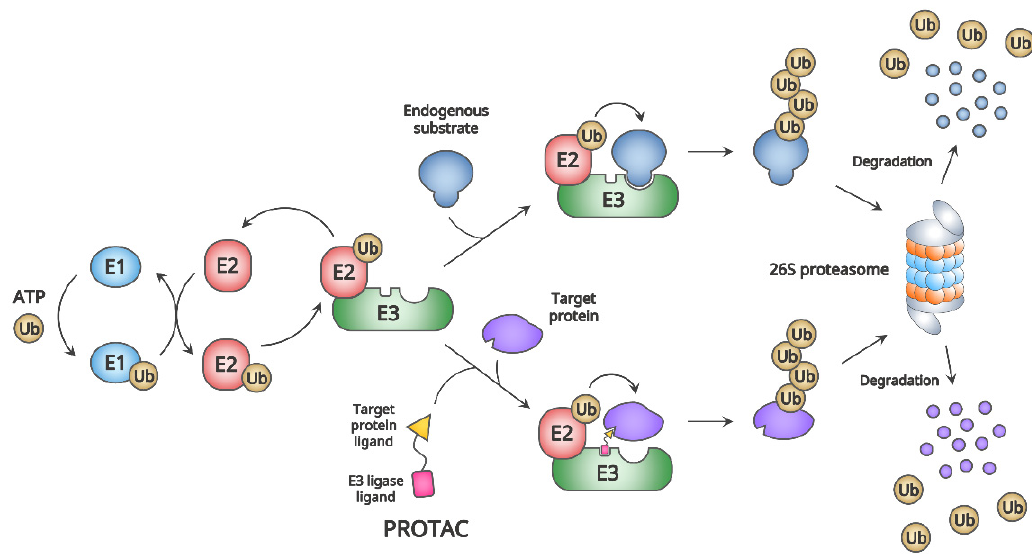
Figure 1. The ubiquitin–proteasome system (UPS) and proteolysis-targeting chimera (PROTAC). For the degradation of a protein through UPS, the ubiquitin (Ub) is linked to an Ub-activating enzyme (E1) via a thioester bond in the ATP-dependent reaction. Next, activated Ub on E1 is transferred to an Ub-conjugating enzyme (E2) through trans-thioesterification. The Ub-ligase (E3) recognizes a degradation signal (degron) of an endogenous substrate and conjugates a Ub from E2 to a lysine residue of the substrate protein. The serial cascades of Ub-activation, Ub-conjugation, and Ub-ligation by E1, E2, and E3 polyubiquitylate the substrate or substrate-conjugated Ub. The 26S proteasome recognizes the polyubiquitin chains on the substrate, subsequently followed by deubiquitylation, unfolding, and degradation of the substrate. The PROTAC can hijack the E3 by its ligand and recruit a target protein for degradation through UPS (adapted from [54,58]).